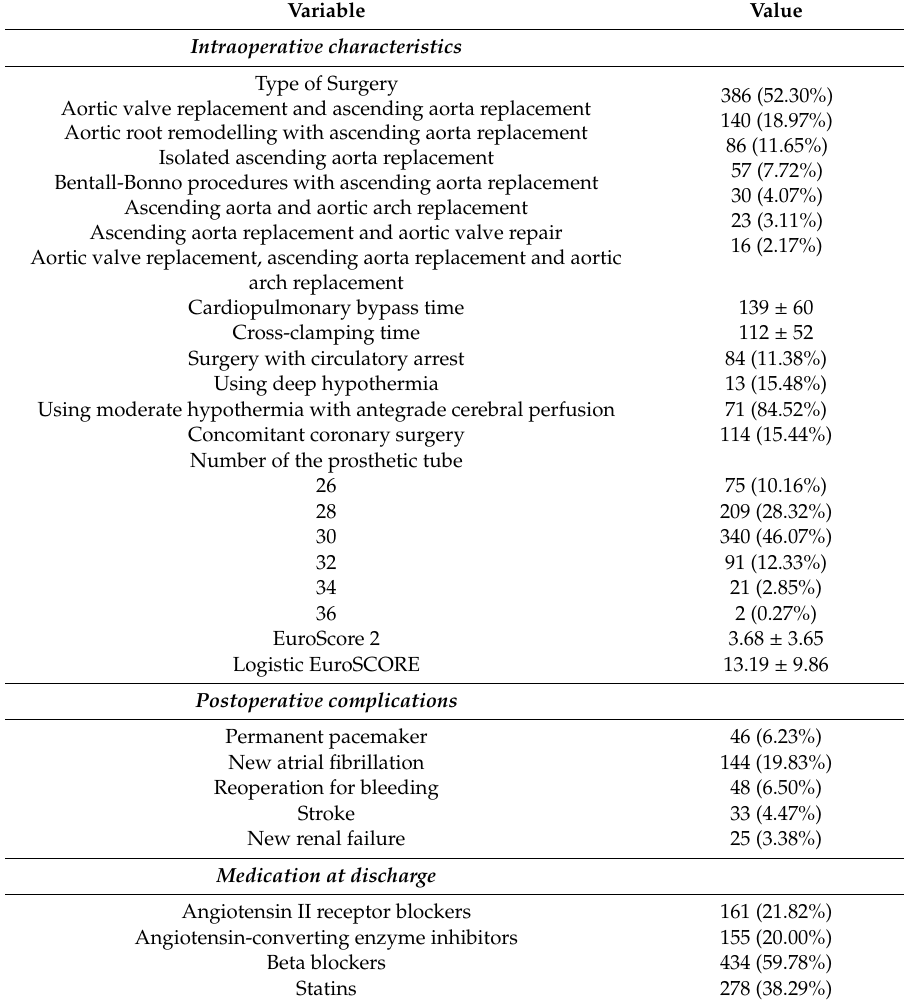
Table 2. Characteristics of the